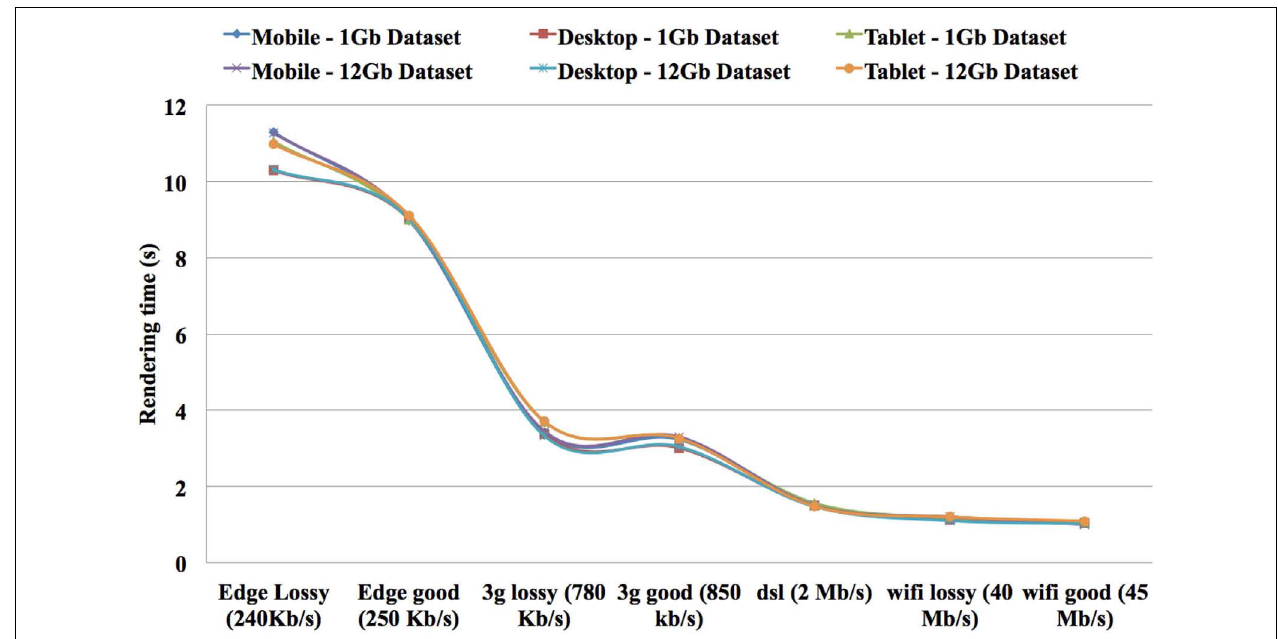
FIGURE 8 | Rendering time compared to link-speed and dataset size from different devices